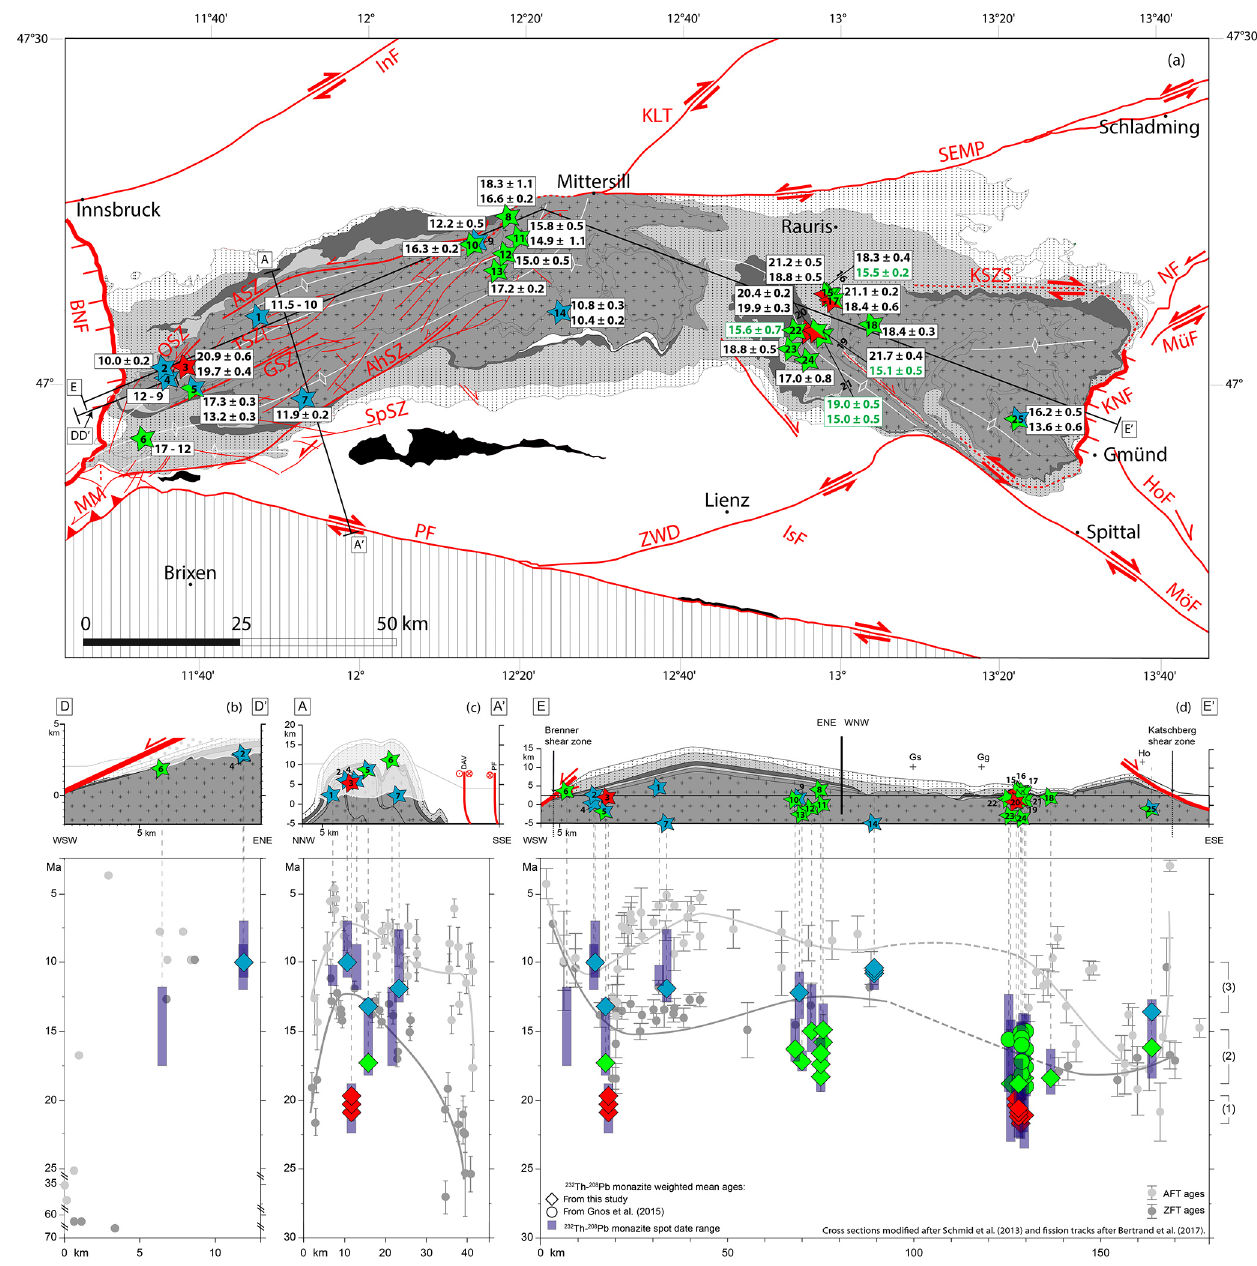
Figure 7. (a) Map of the TW from Fig. 1 with sample locations coloured as function of deformation episodes (coloured stars). See Fig. 1 for legend. (b) DD’ NE–SW cross section across the BNF, (c) AA’ NW–SE cross section perpendicular to the axial plane of the western subdome and (d) EE’ longitudinal cross section parallel to the main axial plane of the TW metamorphic dome, modified after Bertrand et al. (2017). In the upper part, coloured and numbered stars correspond to sample locations and are linked to corresponding Th-Pb monazite ages by dashed vertical lines. Sample numbers refer to Table 1. In the lower part, monazite weighted mean ages from this study and from Gnos et al. (2015) are labelled by coloured diamond and circles, respectively, and the range of single spot dates is depicted by blue bars. The colour code used for diamonds and circles follows deformation episodes explained in the discussion. Note that most error bars are smaller than the size of the diamonds and circles. Zircon and apatite fission track ages are from the Bertrand et al. (2017) compilation; light- and dark-grey dots with error bars are displayed for comparison. Square brackets shown to the right delimit the main periods of monazite growth discussed in the text: (1) early record of N–S shortening and associated E–W extension, (2) contemporaneous N–S shortening and strike slip, (3) reactivation of strike slip to oblique